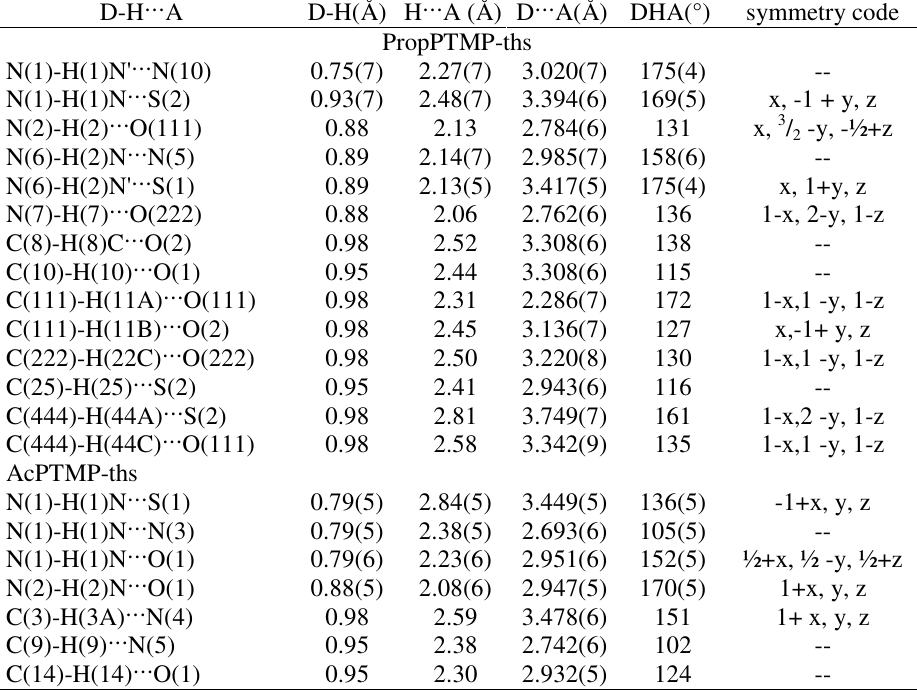
Table 3. Selected parameters for weak interactions in complexes 1 & 2